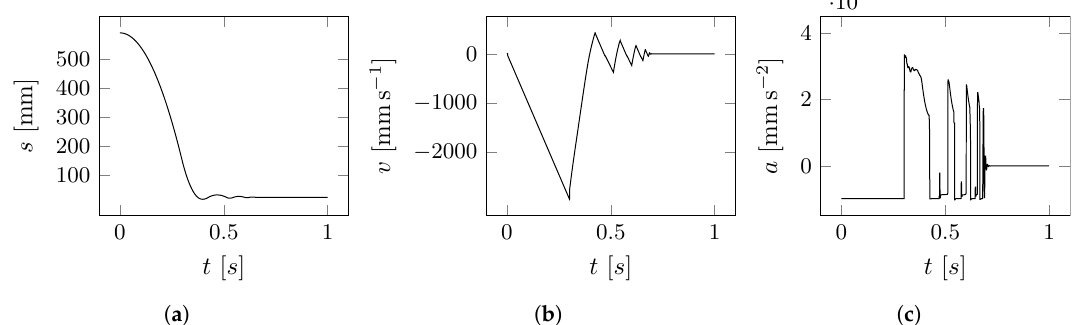
Figure 7. Information about the state of the lander’s MBS along the vertical axis: ( a ) the displacement of the center of mass; ( b ) the velocity; ( c ) the acceleration.